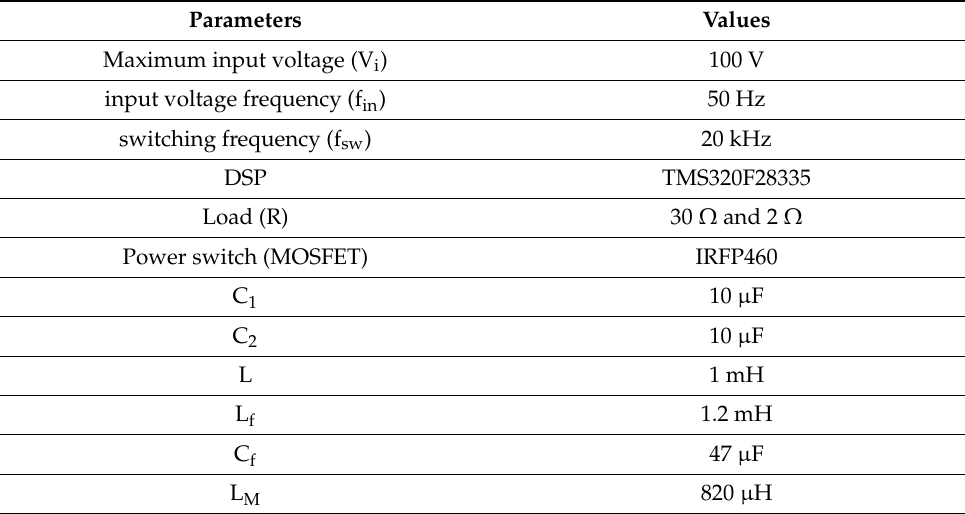
Figure 17. The overview of the implemented test setup. Table 2. Test system properties.